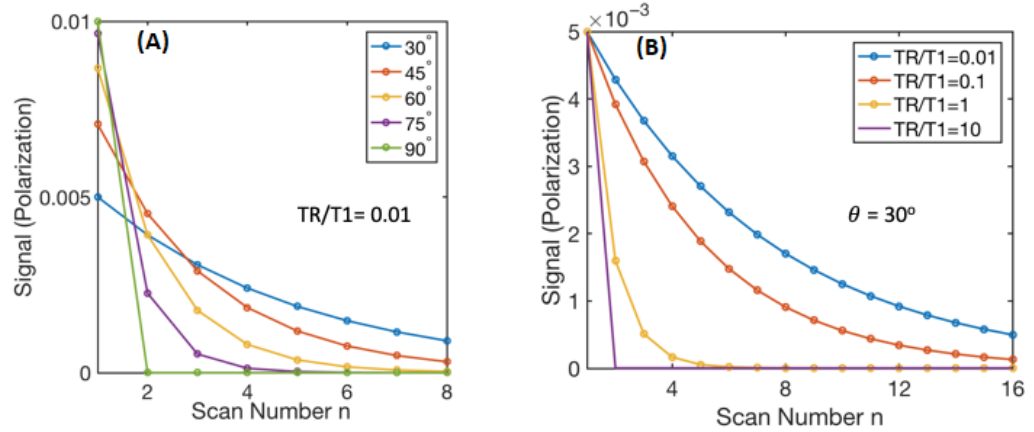
Figure A1. Simulation of signal of each individual repetition as a function of scan number of given TR/T1 in ( A ) and given θ in ( B ). In the simulation, we assume K hp = 10 − 3 and K 0 = 10 − 5 , which approximates the magnetization with our diamond imaging case at